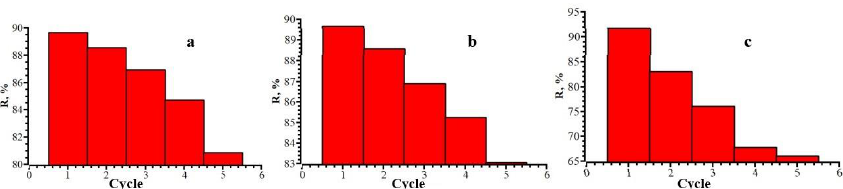
Figure 12. Dependence of the degree of extraction of CZO ( a ), CTX ( b ), and CRO ( c ) on the number of working cycles.